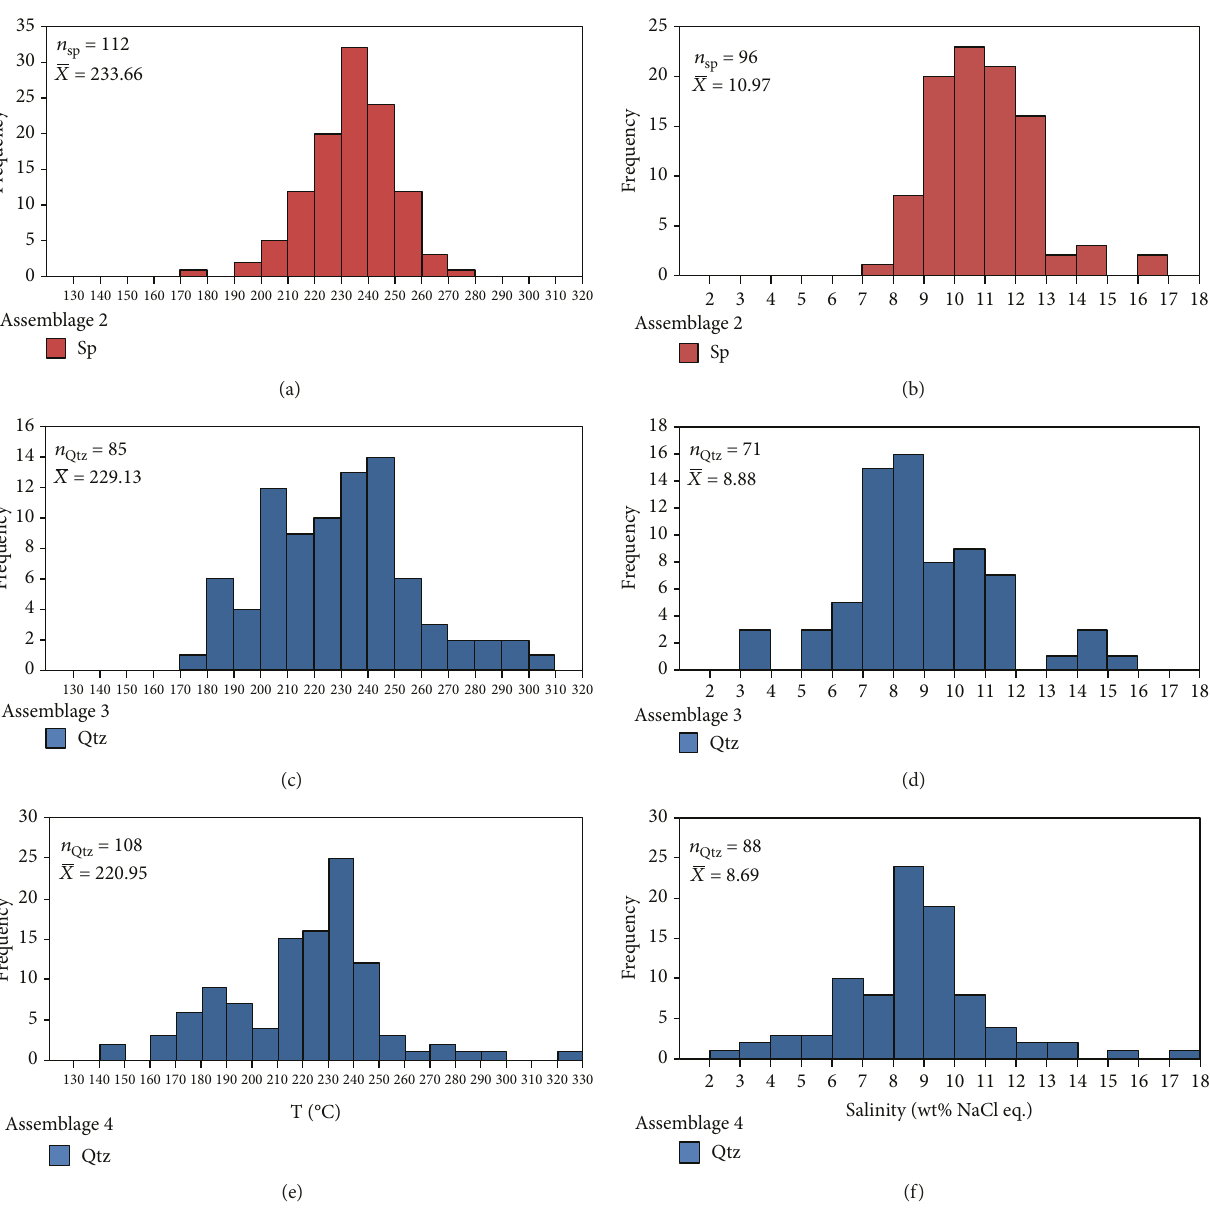
Figure 9: Histograms of homogenization temperature and salinity of FIs in minerals of di ff erent assemblages from the Keyue Sb – Pb – Zn – Ag deposit: (a) and (b) assemblage 2 sphalerite; (c) and (d) assemblage 3 quartz; (e) and (f) Assemblage 4 quartz. Abbreviations are the same as in Figure